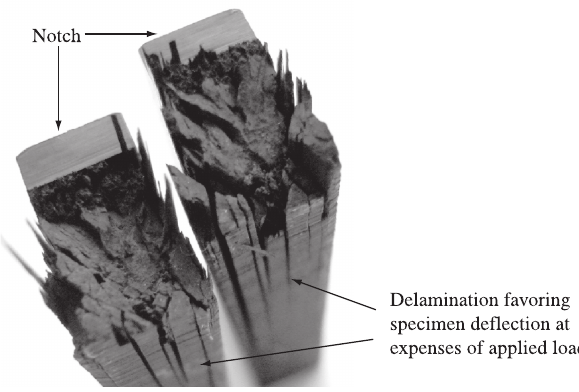
Figure 8. Test piece halves of impacted TP180 laminate tested at –70 °C, with numerous delamination planes (indicated by arrows), promoted